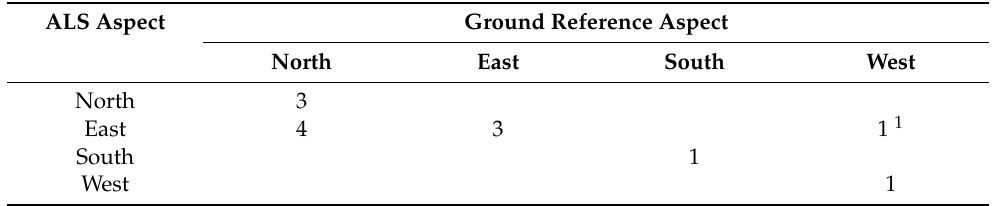
Table 5. Comparison of ALS-derived and ground reference aspect for rock walls and stream gorges. ALS